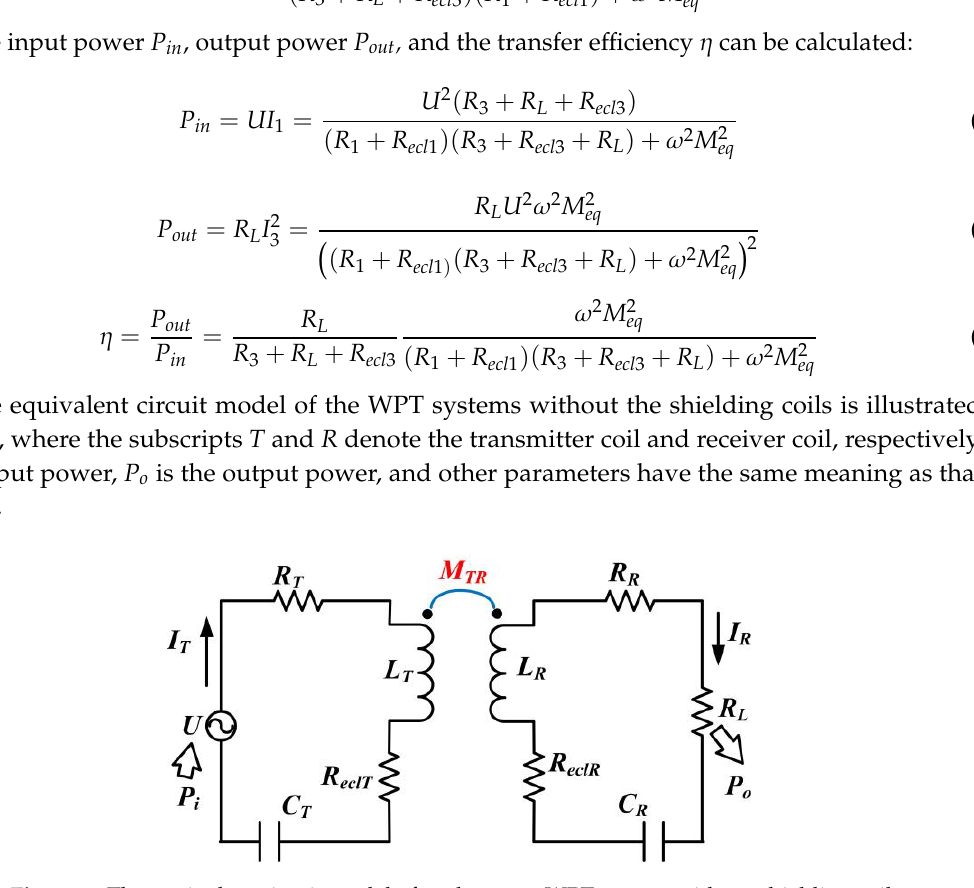
Figure 4. The equivalent circuit model of underwater WPT system without shielding coils.